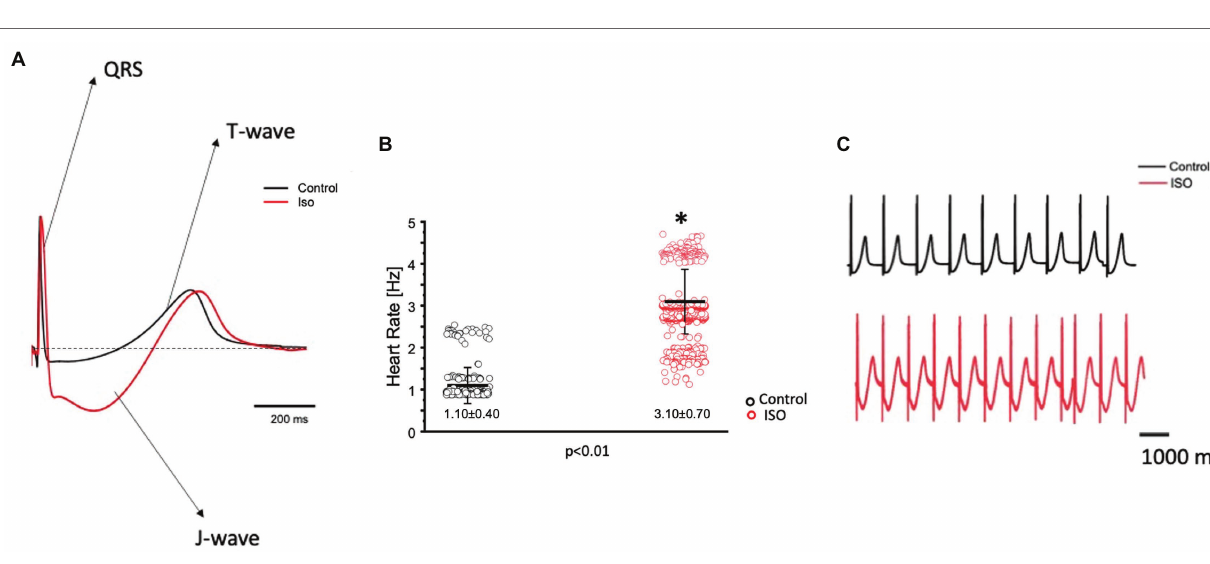
FIGURE 3 | Goldfish ventricular electrocardiogram recordings before (black) and after (red) perfusion with 100 nm isoproterenol. The three main components of the Goldfish electrocardiogram are presented: QRS complex, J wave, and T wave. Application of isoproterenol altered the morphology of the Goldfish electrocardiogram (A) and increased the spontaneous heart rate from 1.10 ± 0.40 Hz to 3.10 ± 0.70 Hz ( p < 0.01, n = 180 for the control, n = 412 for ISO, N = 6; B ). Electrocardiogram recordings before and after isoproterenol perfusion reflect an increased heart rate in response to isoproterenol (C) . * Denotes a significant difference between the two distributions. The data are presented as multiple measurements (n; dot cloud) recorded for different measurements ( n ) on different hearts ( N ) with the mean ± SEM (solid